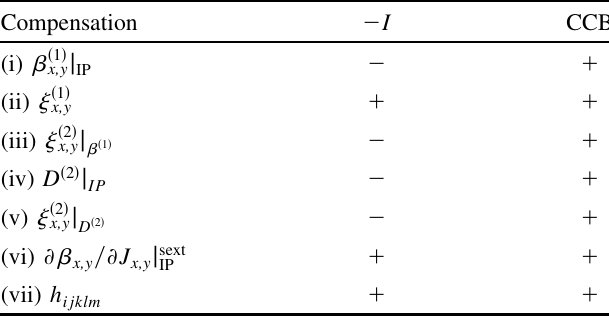
TABLE I. Comparison of the (cid:1) I and CCB schemes. Compensation